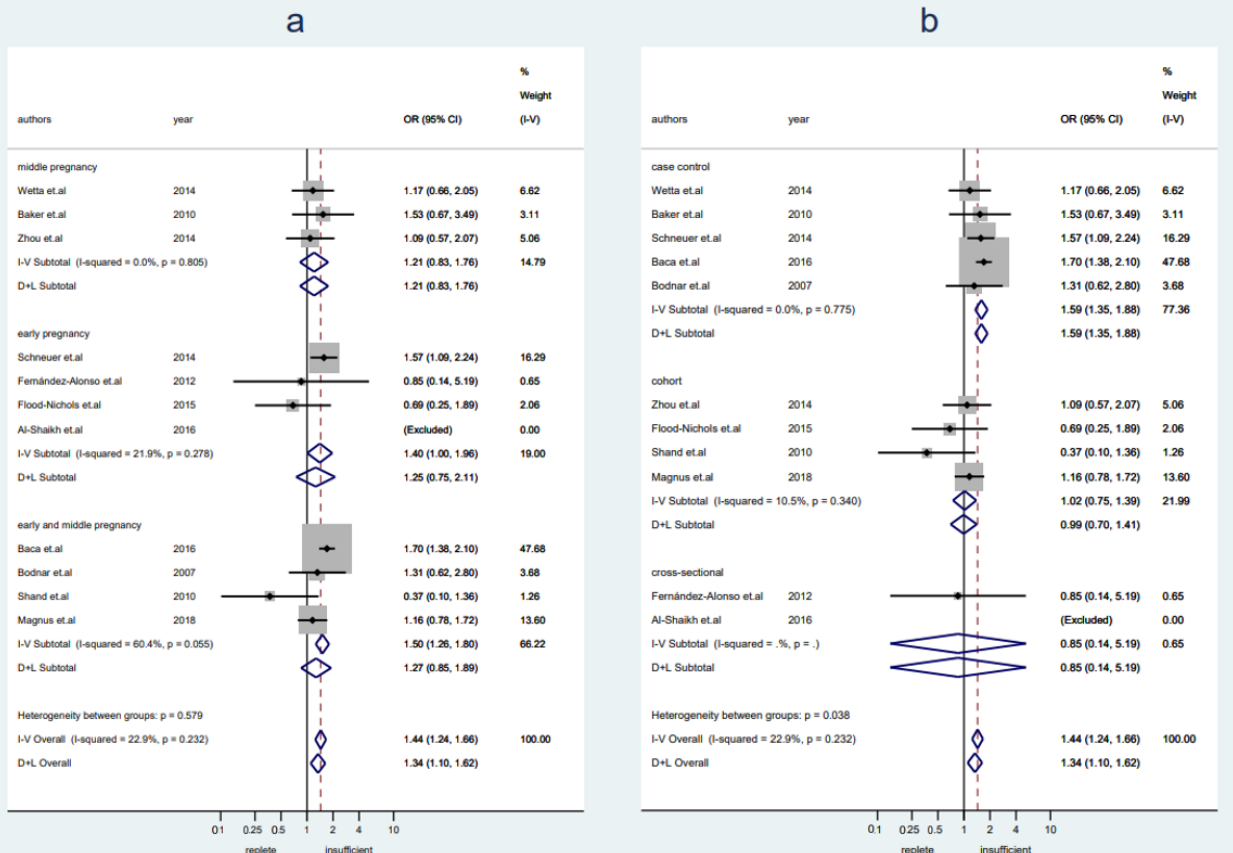
Figure 3. Studies evaluating replete vitamin D levels versus insufficient vitamin D levels. ( a ): Studies were stratified by gestational weeks (early, middle, and early and middle not specified); ( b ): studies were stratified by the study design.